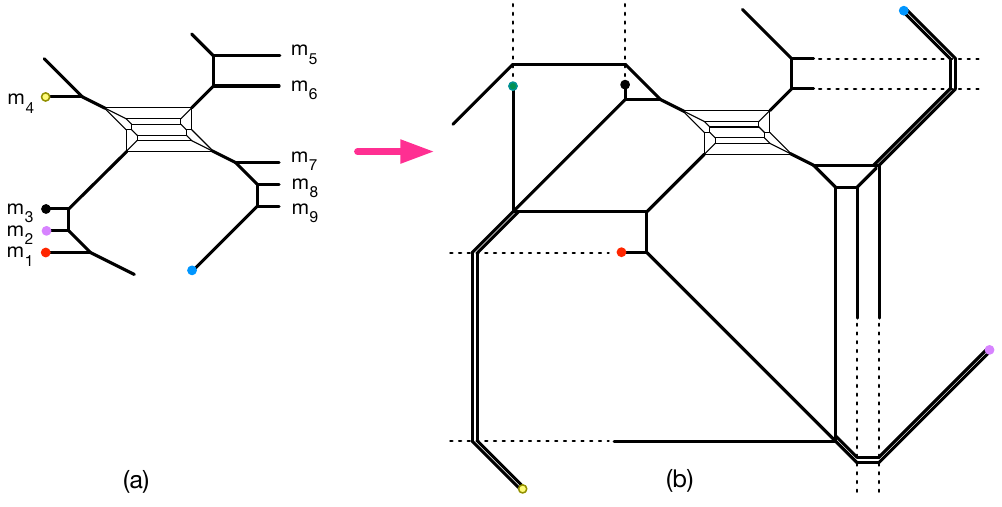
Figure 15 . (a) SU(6) 3 +1 TAS +9 F con(cid:12)guration. (b) SU(6) 3 2 denoted that the thick line means two coincident 5-branes and the dotted lines are the monodromy cuts. 7-brane motions from (a) to (b) are explained in